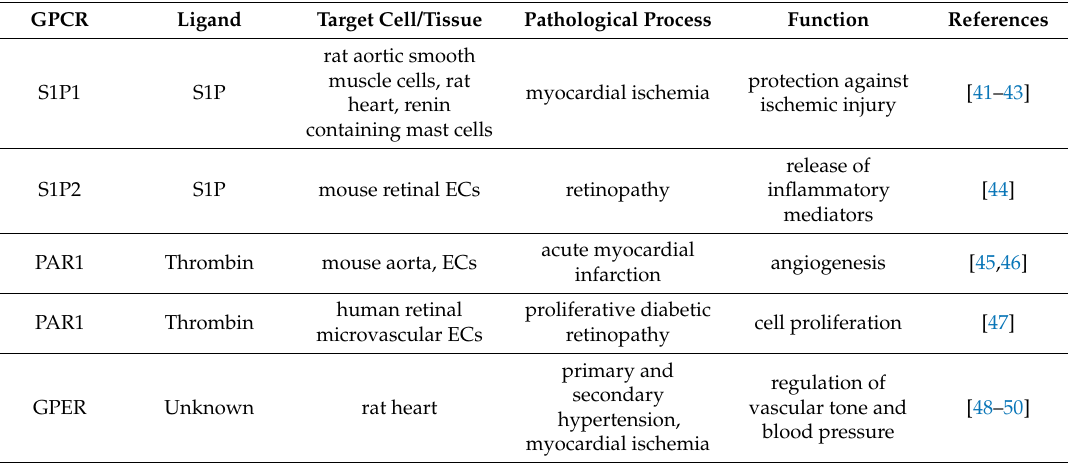
Table 2. GPCRs involved in the regulation of angiogenesis in pathological conditions.